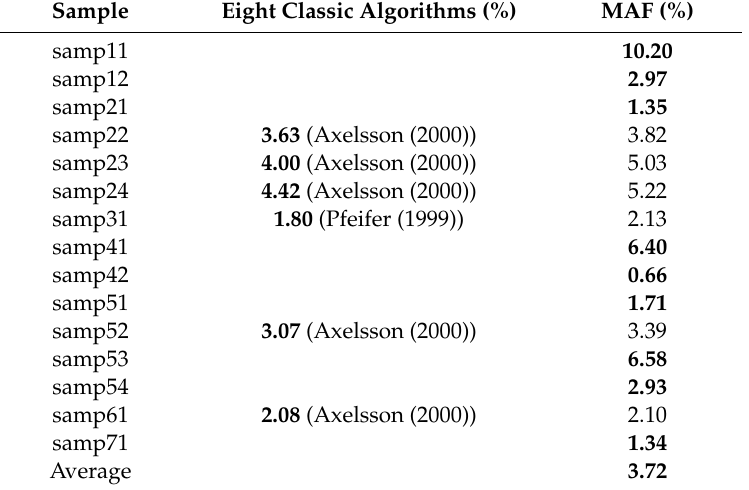
Table 2. Comparison of MAF total errors and the eight classic algorithms for all the ISPRS samples (the bold value is the smallest value in each line and indicates that the corresponding method had the best performance for the study site).